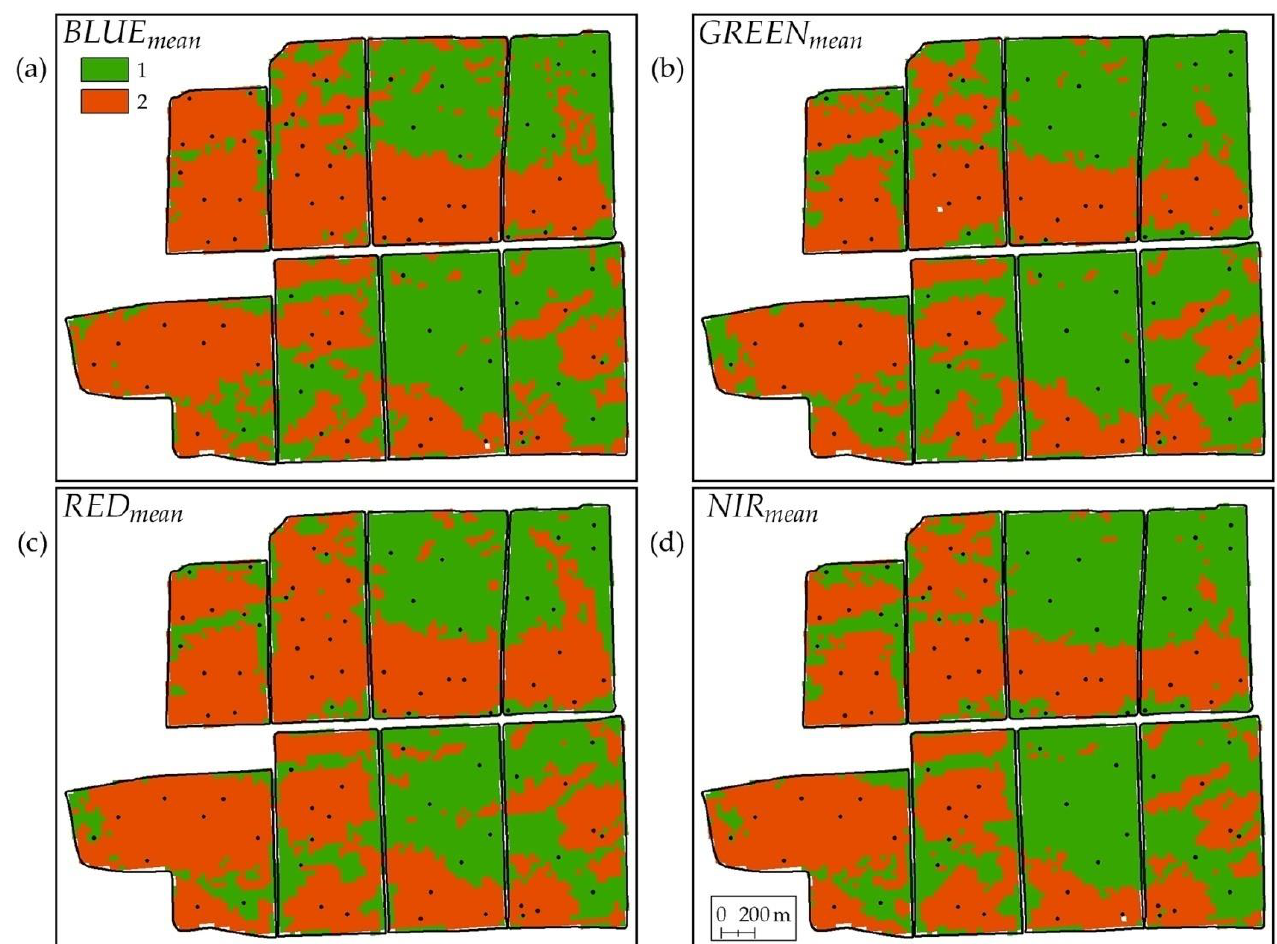
Figure 9. Degradation distribution maps constructed by reclassifying maps of soil interpretations of multi-temporal spectral characteristics: 1 — non-degraded soils, 2 — degraded soils. Table 4. Classification of ranges of the Landsat bands mean values according to soil degradation.